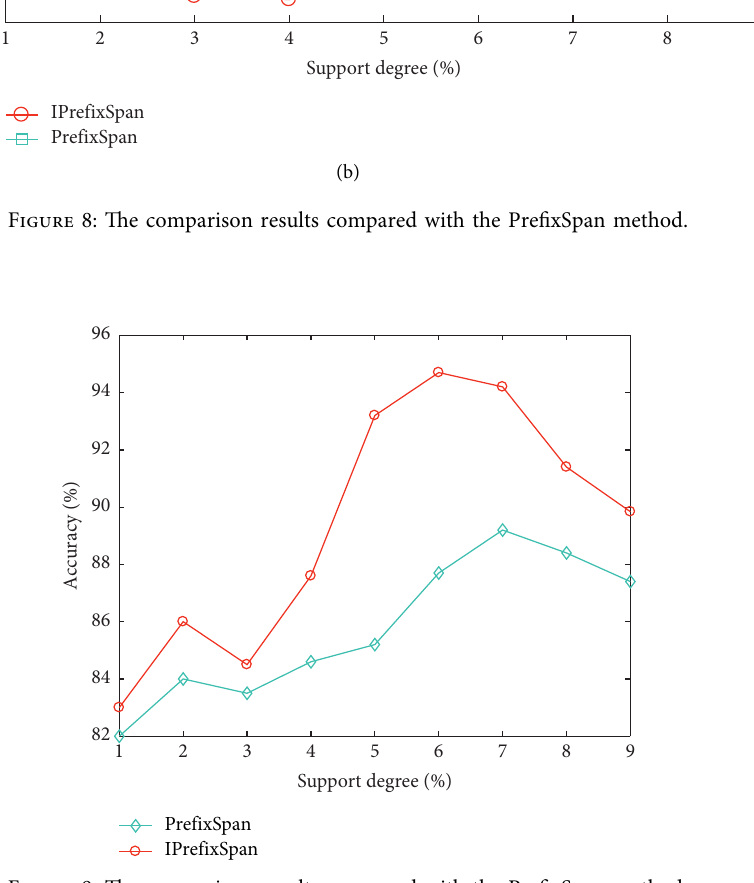
Figure 9: The comparison results compared with the PrefixSpan